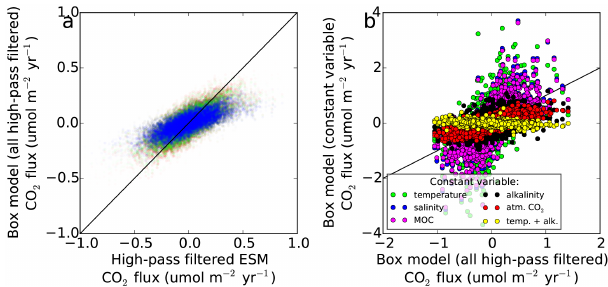
Figure 7. (a) High-pass filtered ESPPE subpolar Atlantic air–sea CO 2 flux plotted against box model estimates of that same flux us- ing the top three box model parameter sets (Table 2) in red, green and blue respectively, but forced with high-pass filtered input time series. (b) All box model inputs high-pass filtered plotted against all box model inputs high-pass filtered but one variable held constant. The constant variable in each case is named within the legend. All results are presented as anomalies from the